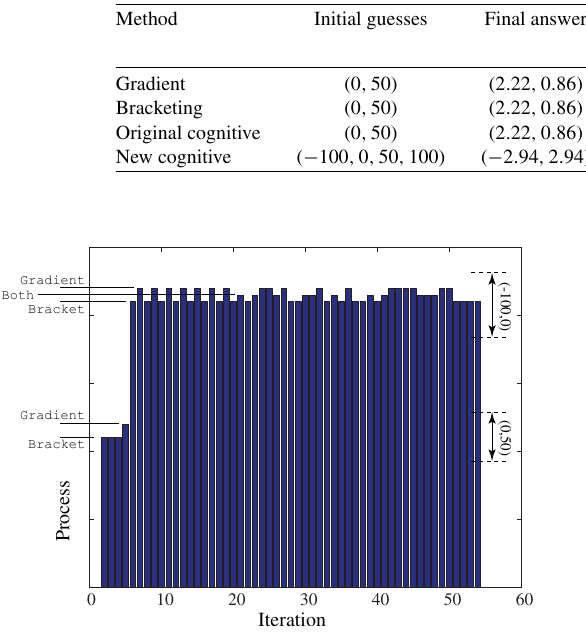
Table 3 Comparison of Bracket, Gradient, and Original and New Cognitive Search Algorithms.